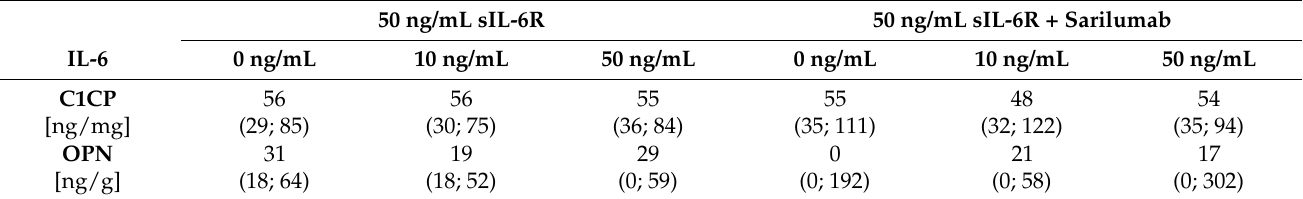
Table 3. Concentrations of the c-terminal propeptide of collagen 1 (C1CP; n = 12 independent donors in passage 3 (female: n = 8, male: n = 4); mean age: 67.3 ± 16.1 year) and osteopontin ( n = 4 independent donor (female: n = 3, male: n = 1; mean age: 77.5 ± 5.1 year)— n = 5